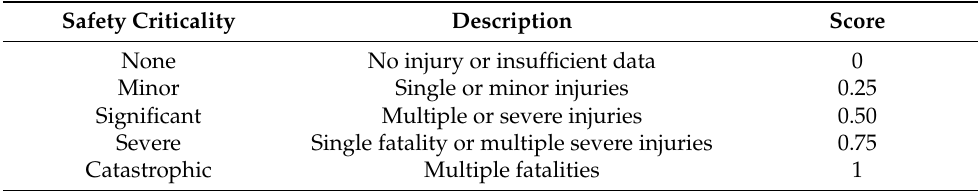
Table 5. Estimation criteria for safety criticality.